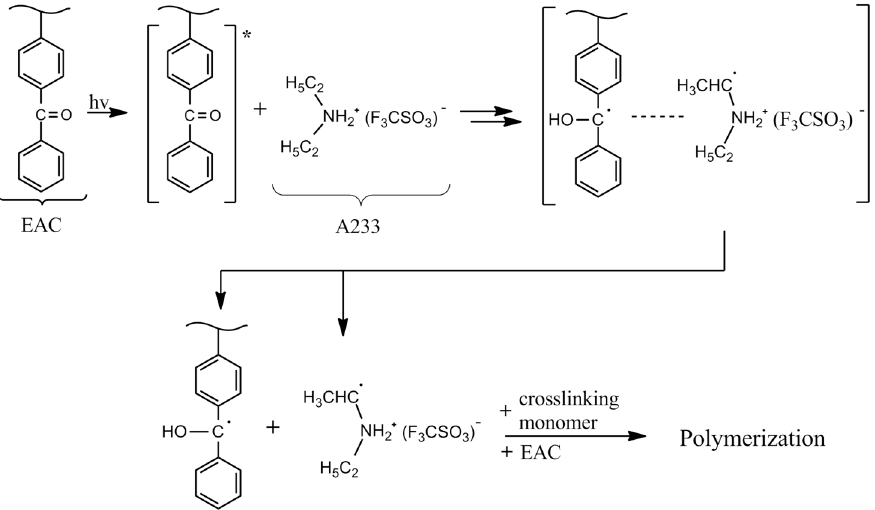
Figure 6. Photoinitiated free radical polymerization of the EAC and the cross-linking monomer (Laromer 9023) using the amine salt as the hydrogen donor.